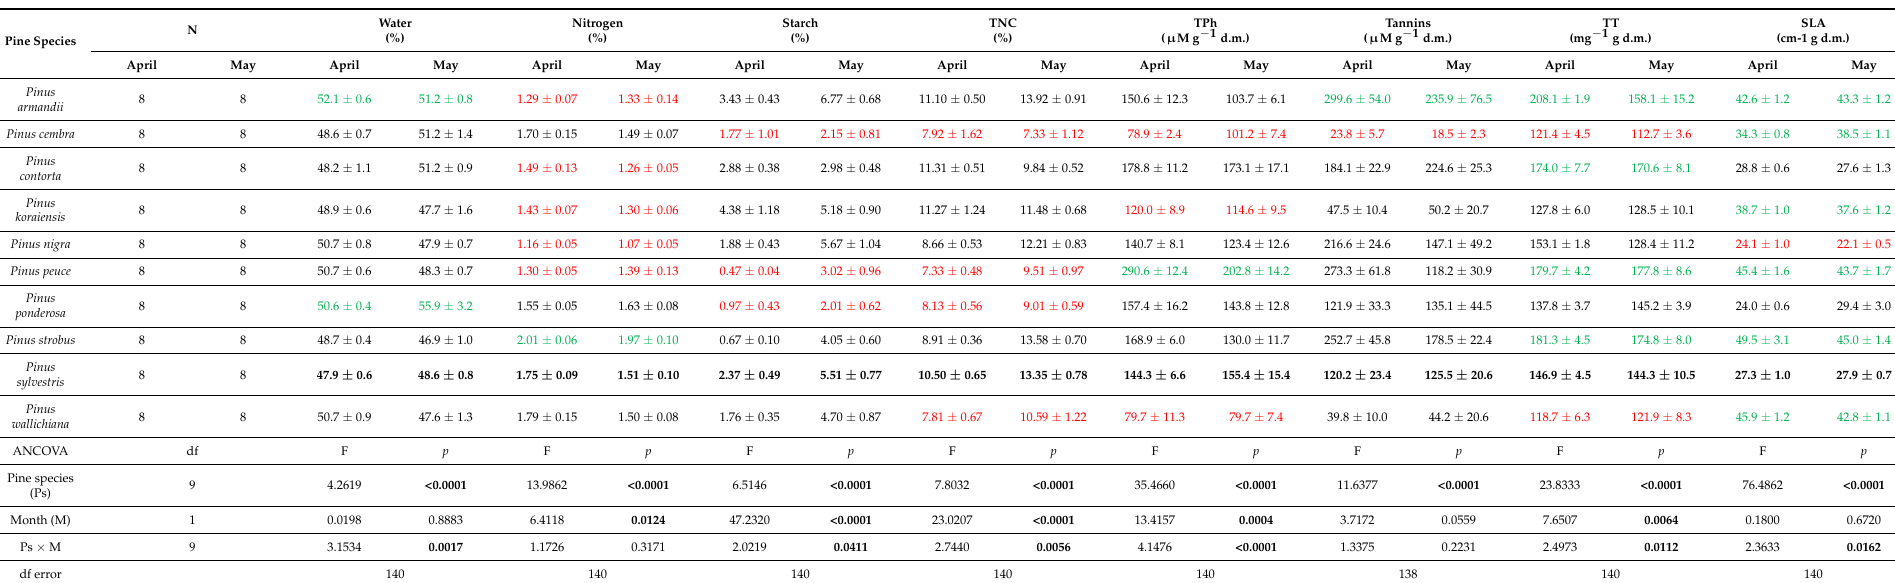
Table A3. Means and standard errors ( ± SE) and summary of the results of analysis of variance (ANOVA) for water, nitrogen, starch, total non-structural carbohydrates (TNC), total phenols (TPh), tannins, total terpenoids (TT), and specific leaf area (SLA) in one-year-old needles of 10 different pine species (Ps), achieved over two consecutive months of collection of plant material (M)—in April and in May. Statistically significant differences p < 0.05 are marked in bold. Mean values marked in red mean that they are significantly lower than the value for the control (bolded; Dunnett’s test used here; α = 0.05), green values indicate higher ones, and black—non-significant differences. The Dunnett’s test was performed for the Ps factor, so there was no month differentiation, thus two cells (for April and May) are marked in